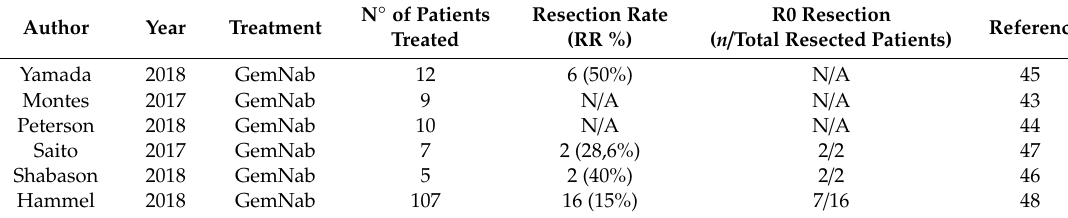
Table 5. Studies evaluating GemNab included in the systematic